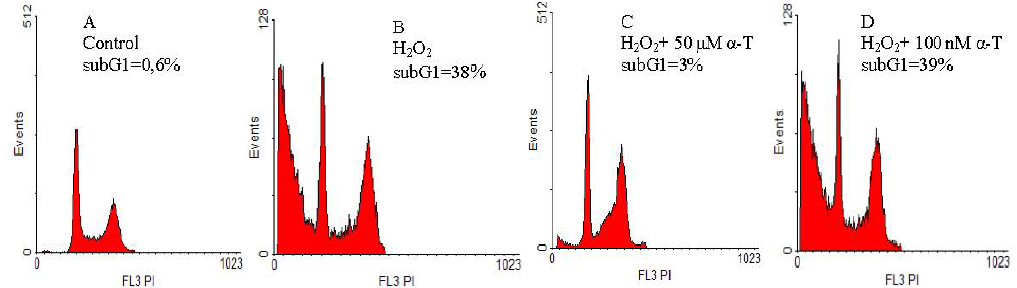
Figure 4. The figure shows effect of pre-incubation for 0.5 h with α -T prior to PC12 cell exposure to 0.2 mM H O for 24 h on the relative number of PC12 cells in late apoptosis 2 2 (% of the total cell number). The results of one typical experiment from four replicates are presented. The relative value of the subG1 hypodiploid peak (left on the histograms) corresponds to the relative number of PC12 cells in late apoptosis. In this figure: ( A ) control; ( B ) H O ; ( C ) H O + pre-incubation with 50 μ M α -T; ( D ) H 2 2 2 2 pre-incubation with 100 nM α -T. In the control sample, the relative number of cells in late O markedly increases the number of cells apoptosis ( A ) is less than 1%, but exposure to H 2 2 in this peak ( B ). The pre-incubation of PC12 cells with 50 μ M α -T for 0.5 h prior to their exposure to H O decreases the hypodiploid peak from 38% ( B ) to 3% of total cell 2 2 numbers ( C ), while pre-incubation with 100 nM is not effective, as it does not change the number of cells in this peak ( D ).